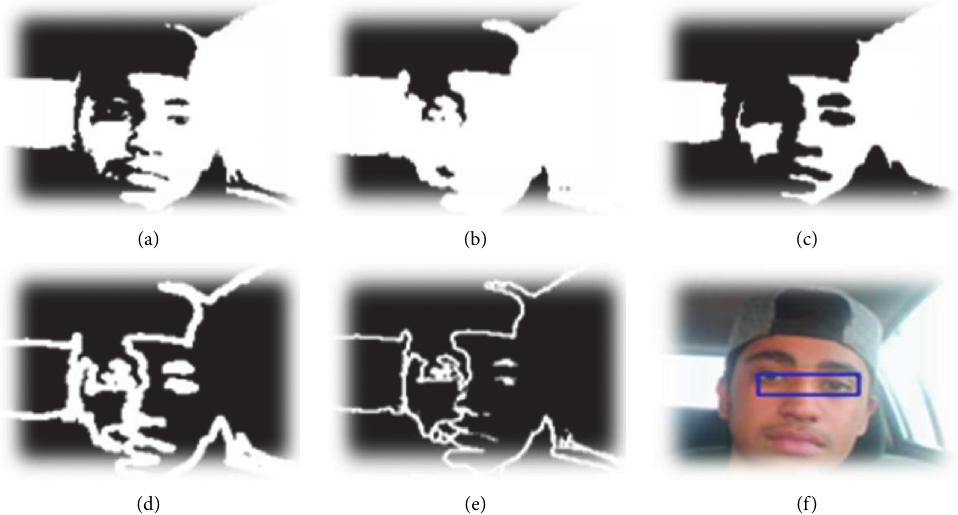
Figure 6: Flat structuring element to detect the eye region. (a) Original image. (b) Dilated image. (c) Eroded image. (d) Internal boundary. (e) External boundary. (f) Eyes